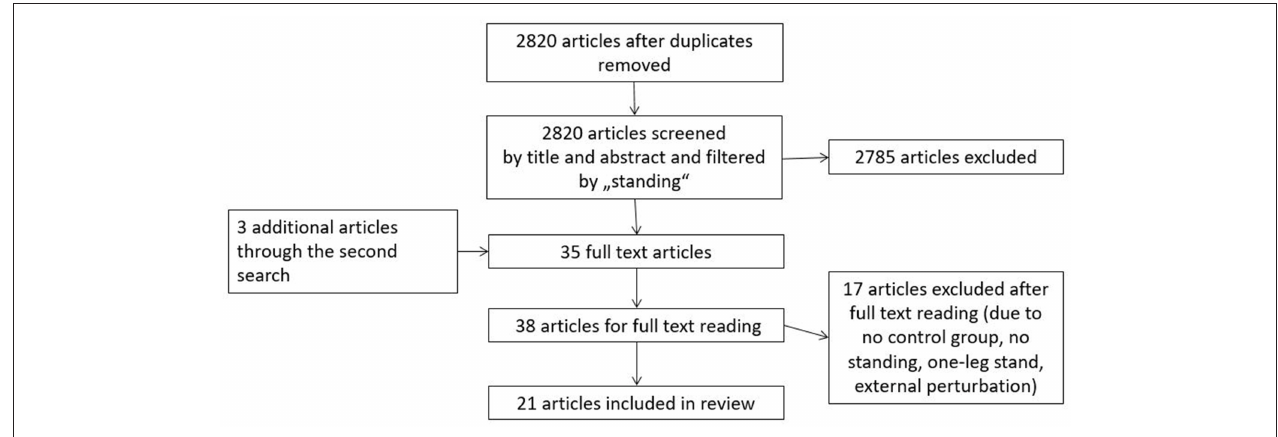
FIGURE 1 | Flow chart of search strategy and study